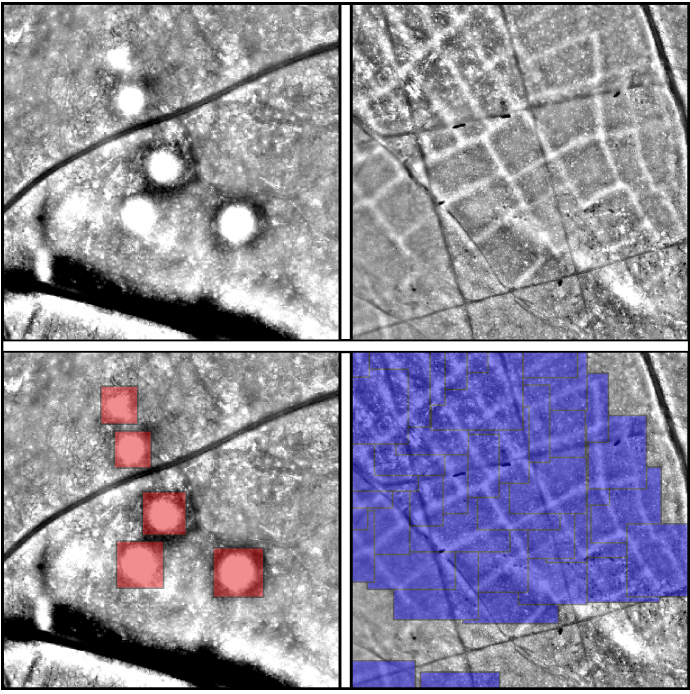
Figure 2. Excerpts of LiDAR data, visualised with a Simple Local Relief Model [31], showing: barrows ( left ) and Celtic fields ( right ). The bottom row shows the corresponding annotations (source of the elevation model: Ref.